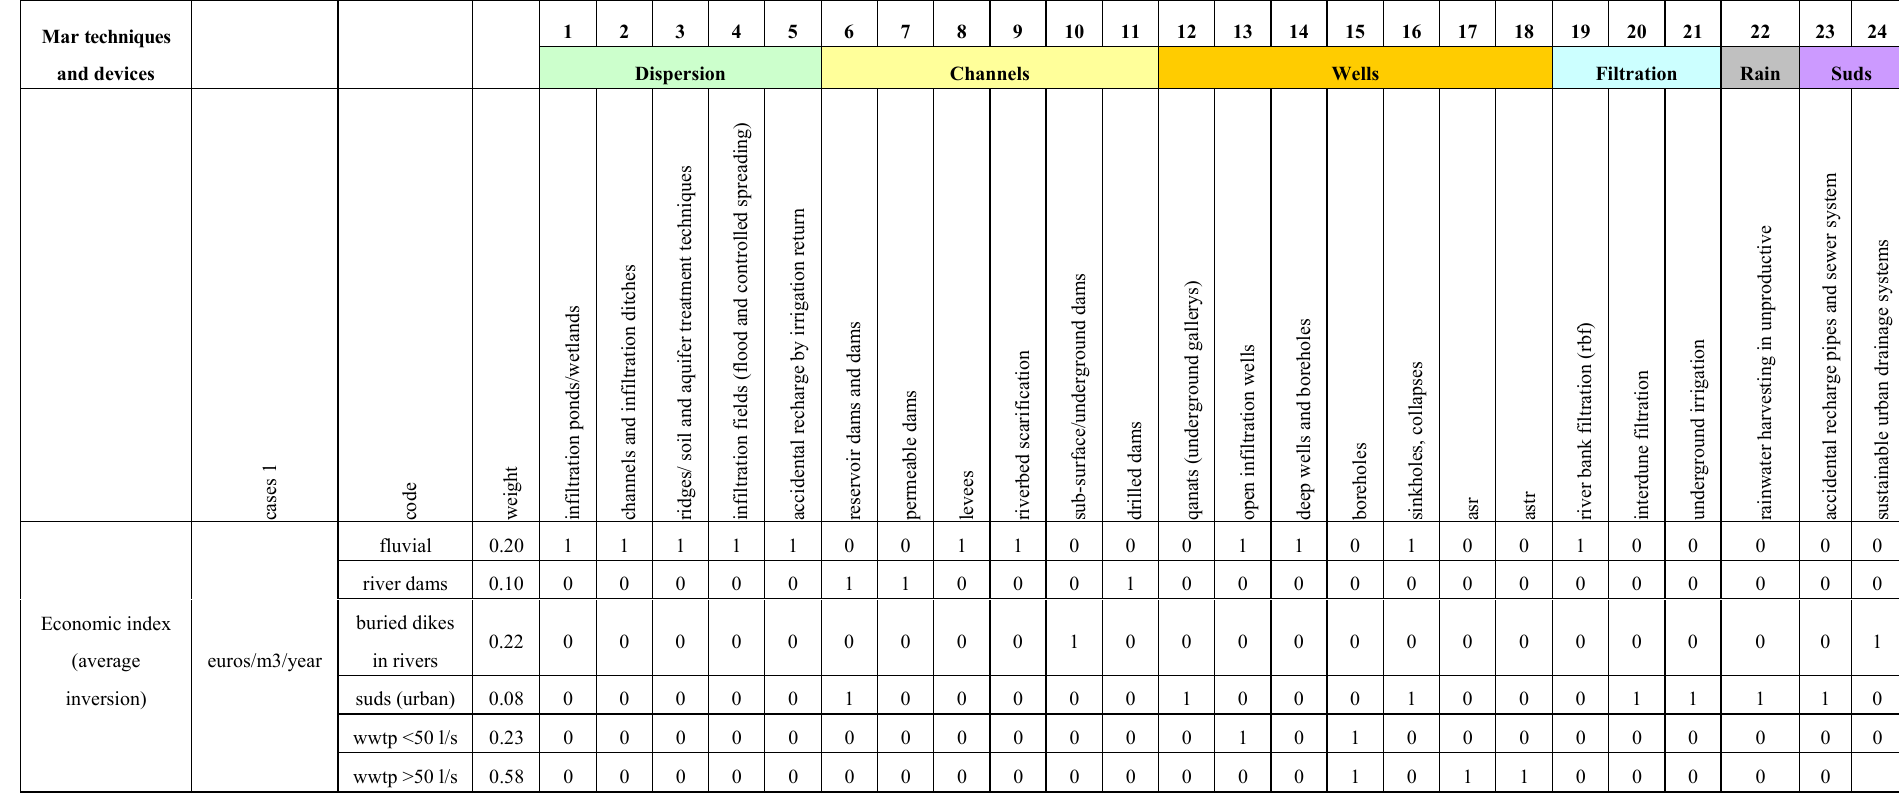
Table 4. The averaged economic index prior to connection with inventoried devices and “MAR zones” in the “HydroGeoportal DINA-MAR” iso-costs layer. The top numbers are specified in Figure 2 (inventory). 1/0 indicates applies/not